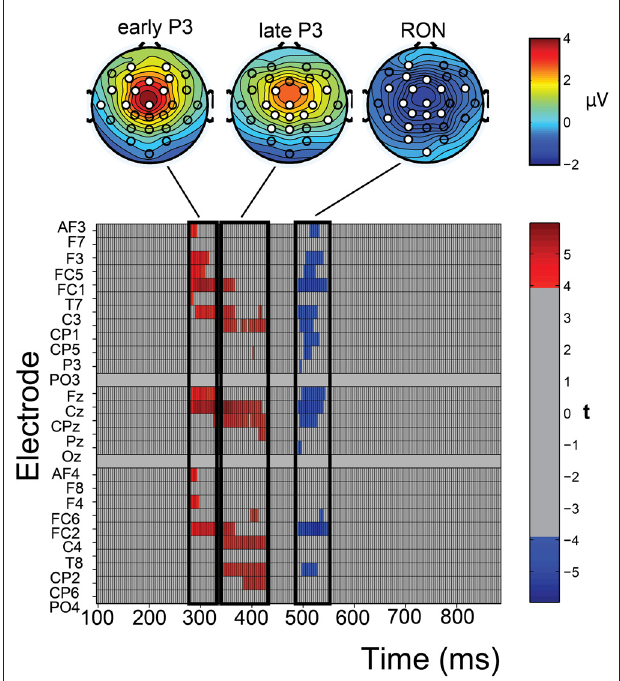
FIGURE 5 | The raster diagram (bottom) shows the comparison results of the environmental distractor ERPs across viewing and steering trials. A mass univariate analysis analyzed every time point (256 Hz) between 100–900 ms for all 26 electrodes. Red/blue rectangles represent time points and electrodes where the difference between the ERPs in the viewing and steering trials was significantly positive/negative. Scalp topographies are provided (top) for the three significant time-intervals where significant differences were found. Scalp potential amplitudes are illustrated as heat maps and significant electrodes that differentiated between the viewing and steering conditions are marked